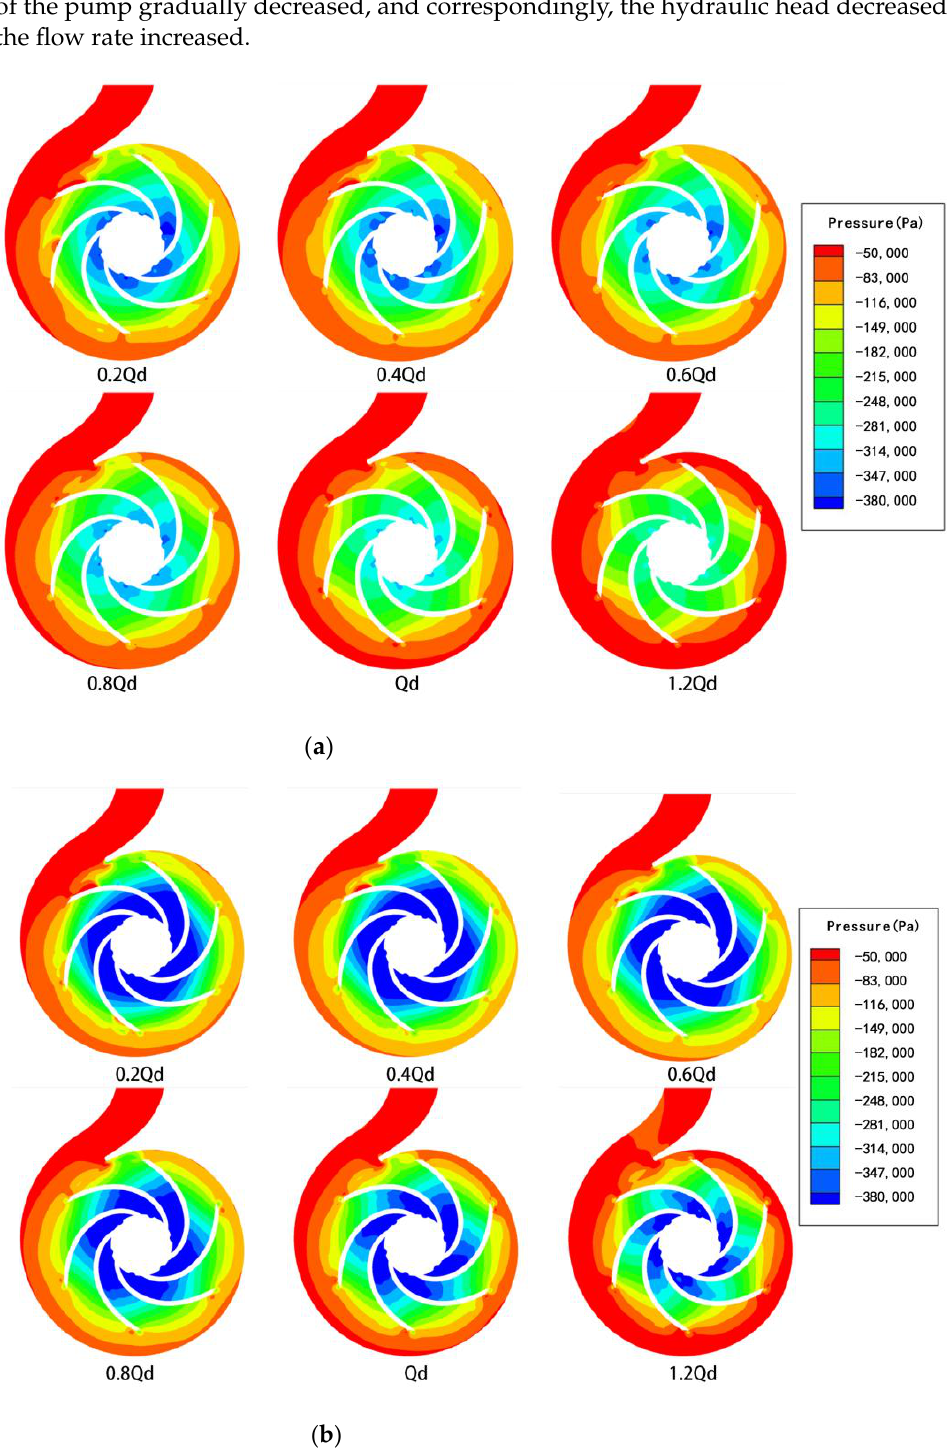
Figure 7. Pressure contours in the centrifugal pump. ( a ) Cases with water; ( b ) cases with drilling fluid.